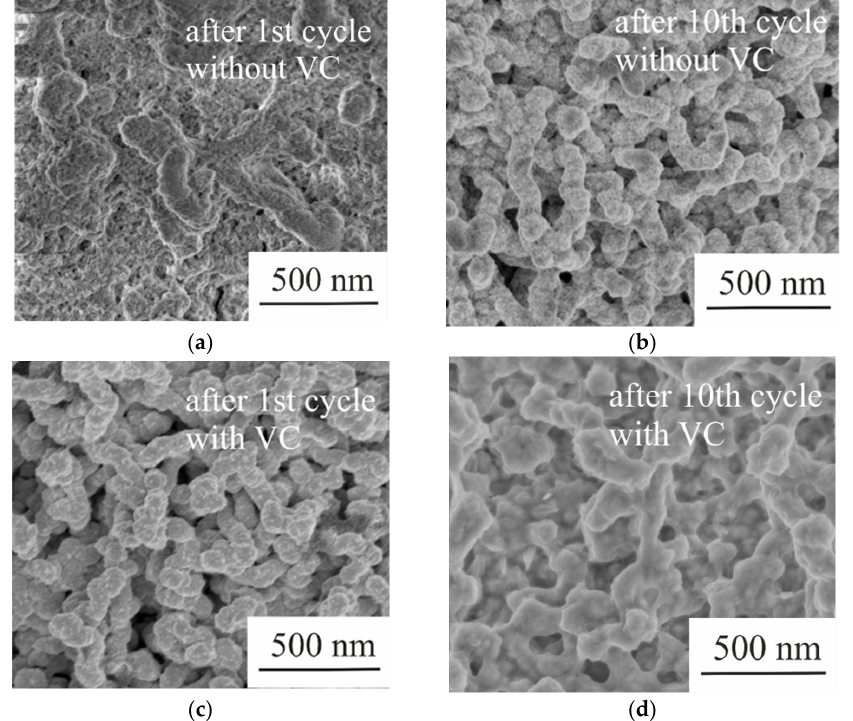
Figure 5. SEM images of the surface morphology of the samples after cycling in without-VC ( a , b ) and with-VC ( c , d ) electrolyte solution.